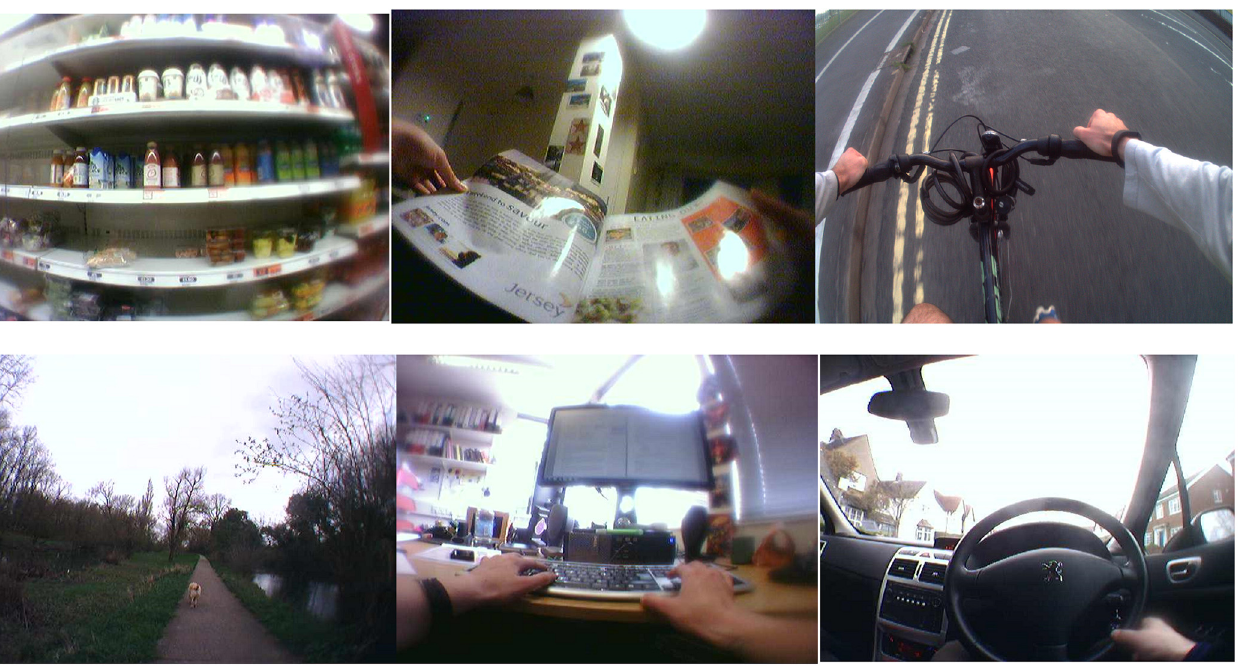
Fig 2. Sample of participants Autographer images from Pilot Study. Clockwise (from top left) these show the following activities with their appropriate HETUS Level one codes: food shopping (3: Household and family care), reading a magazine (8: Mass media), cycling (9: Travel), driving (9:Travel), computer use (1: Employment), and walking (6: Sports and outdoor